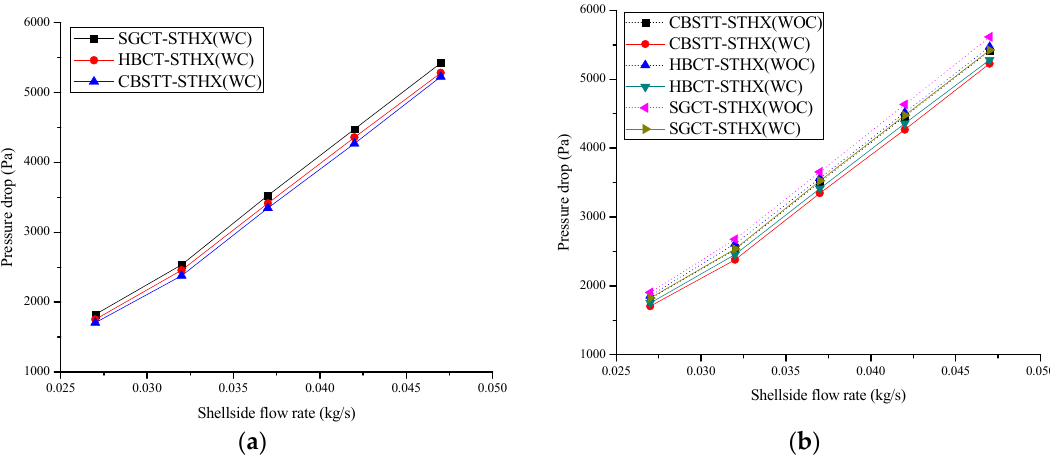
Figure 8. Pressure drop: ( a ) Shell side pressure drop versus mass flow rate and ( b ) pressure drop comparison of three STHXs, with and without tube-to-baffle-hole clearance.